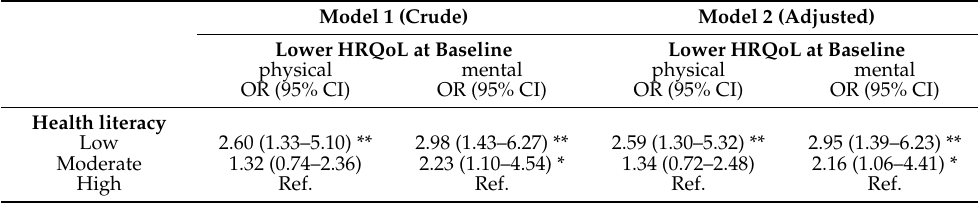
Table 2. Association of health literacy (HL) with lower health-related quality of life (HRQoL) at baseline, crude (model 1) and adjusted for Charlson comorbidity index, vascular access, dialysis effectiveness, age and gender (model 2): results of logistic regression analysis leading to odds ratios (OR) and 95% confidence intervals (CI), n = 413, patients from 20 dialysis clinics in Slovakia.